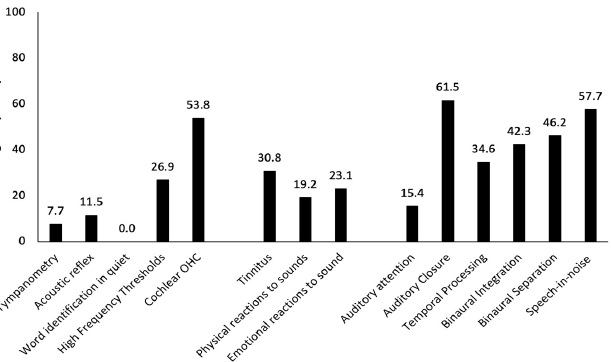
Figure 1. Percentage of TBI participants with a particular auditory dysfunction. Table 1. Odds ratio (OR) of auditory dysfunction experienced by participants with several TBIs compared to those with only one TBI or with blast-related force TBI compared to those with blunt TBI. The 95% confidence interval (CI) and p -values ( p ) are